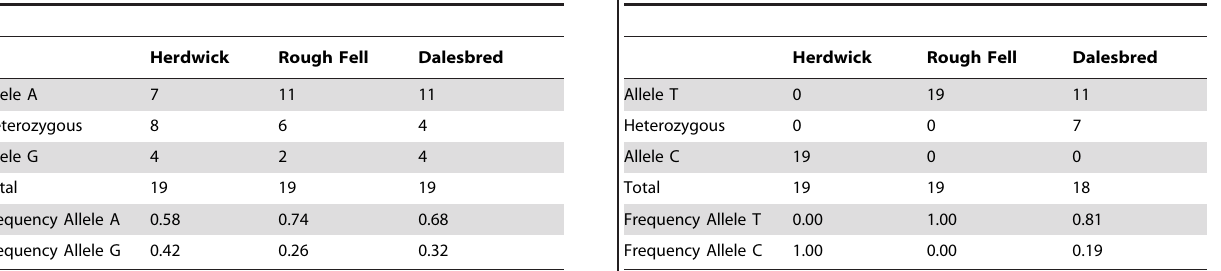
Table 4. Genotype classes and frequencies of alleles for SNP locus OAR10_29511510 (horn associated).